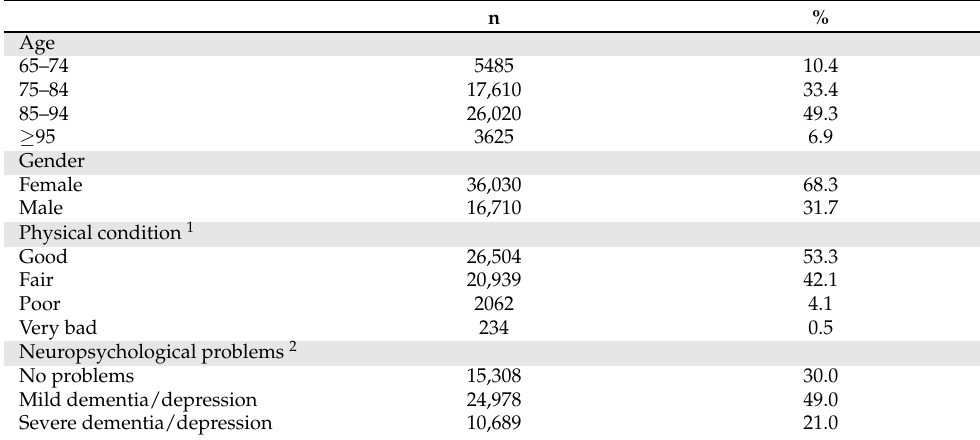
Table 2. Characteristics of study population (n = 52,740).